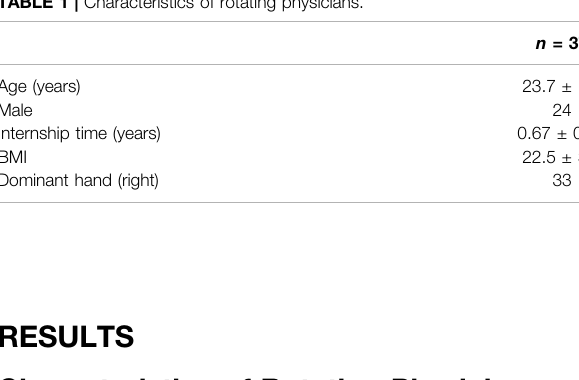
TABLE 1 | Characteristics of rotating